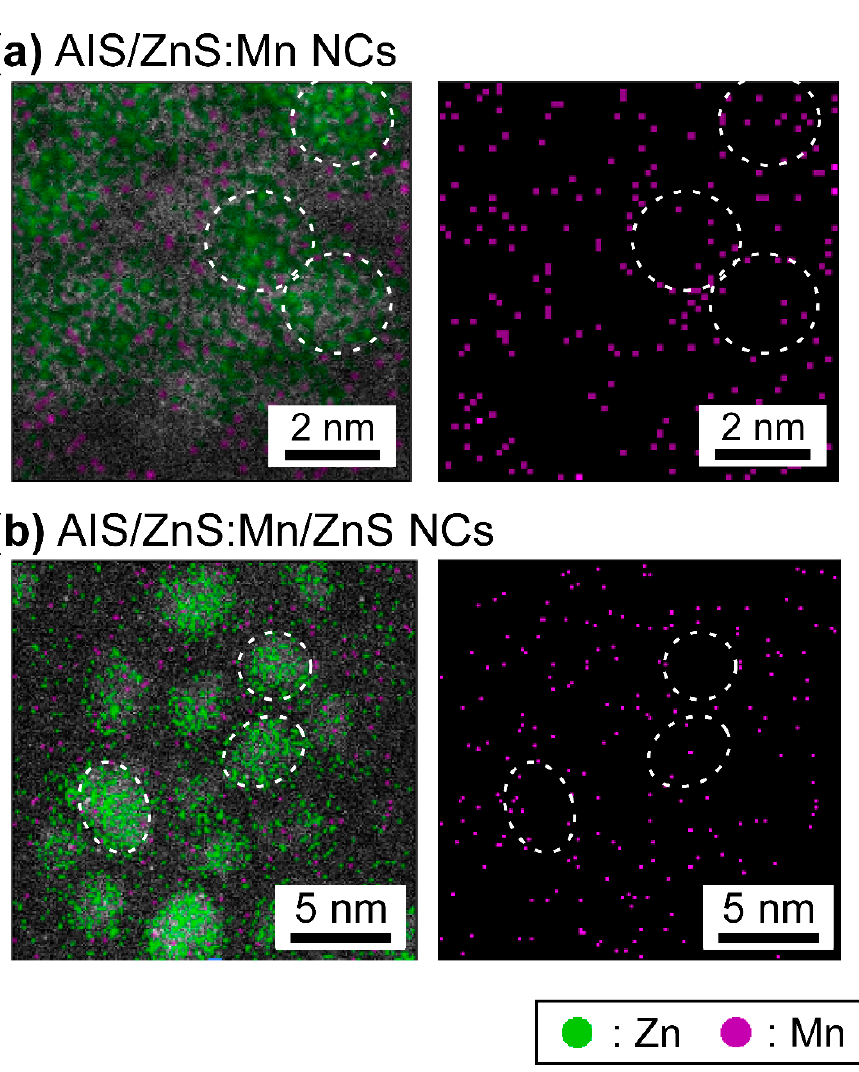
Figure 3. Microscopic elemental mapping images of AIS/ZnS:Mn NCs ( a ) and AIS/ZnS:Mn/ZnS NCs ( b ) observed by the ARM. Green and purple dots in the images indicate Zn and Mn, respectively, and the circular spots correspond to the single NCs.